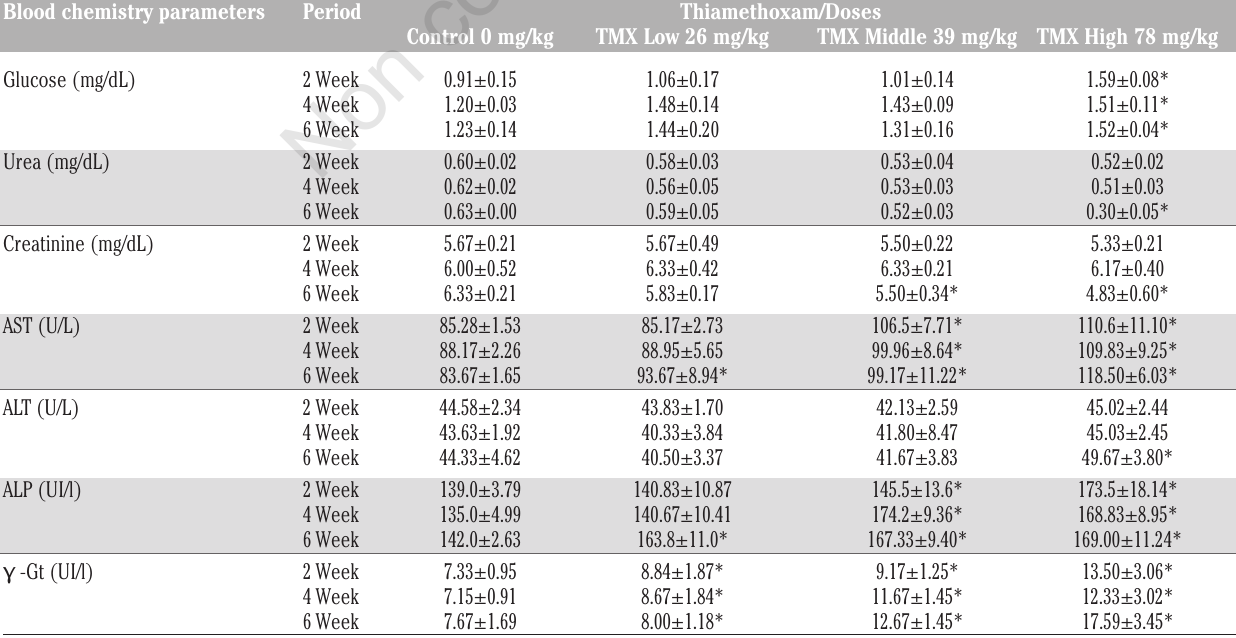
Table 3. Biochemical data of male rats orally administered thiamethoxam for 6 weeks. Blood chemistry parameters